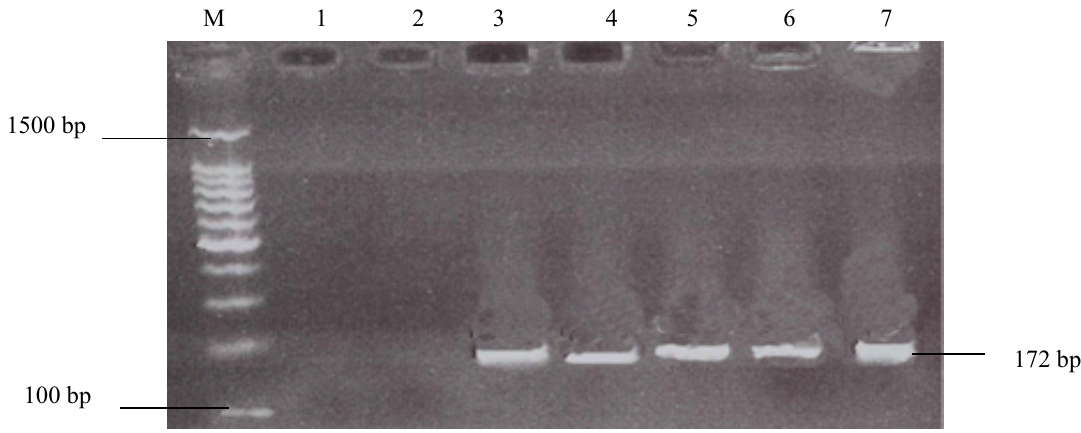
Fig. 1. Agarose gel electrophoresis of PCR tmr detection from Agrobacterium isolates. Lane M, 100 bp molecular size marker; lane 1, water control; lane 2, DNA from Agrobacterium C58c1; lane 3, DNA from Agrobacterium C58; lanes 4–7, DNA from selected Jordanian